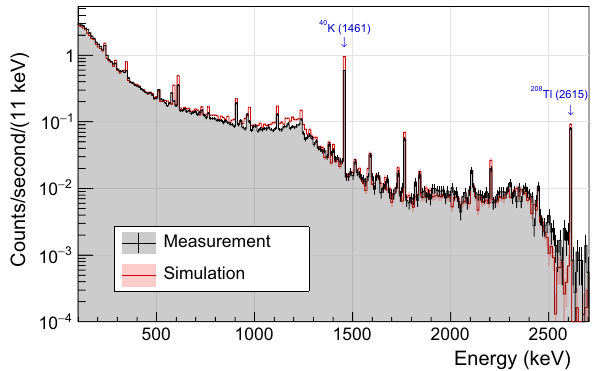
Fig. 3 The energy spectrum measured by a HPGe detector in the spec- trometer hall (grey), and the simulated spectrum for energy deposited in a germanium crystal by gammas originating from a 0.6 m by 0.6 m region of the concrete wall (red). The simulated spectrum has been nor- malized to the measured spectrum, with a normalization factor of 5.8. Prominent lines from 208 Tl ( 232 Th decay chain) and 40 K are labeled for reference